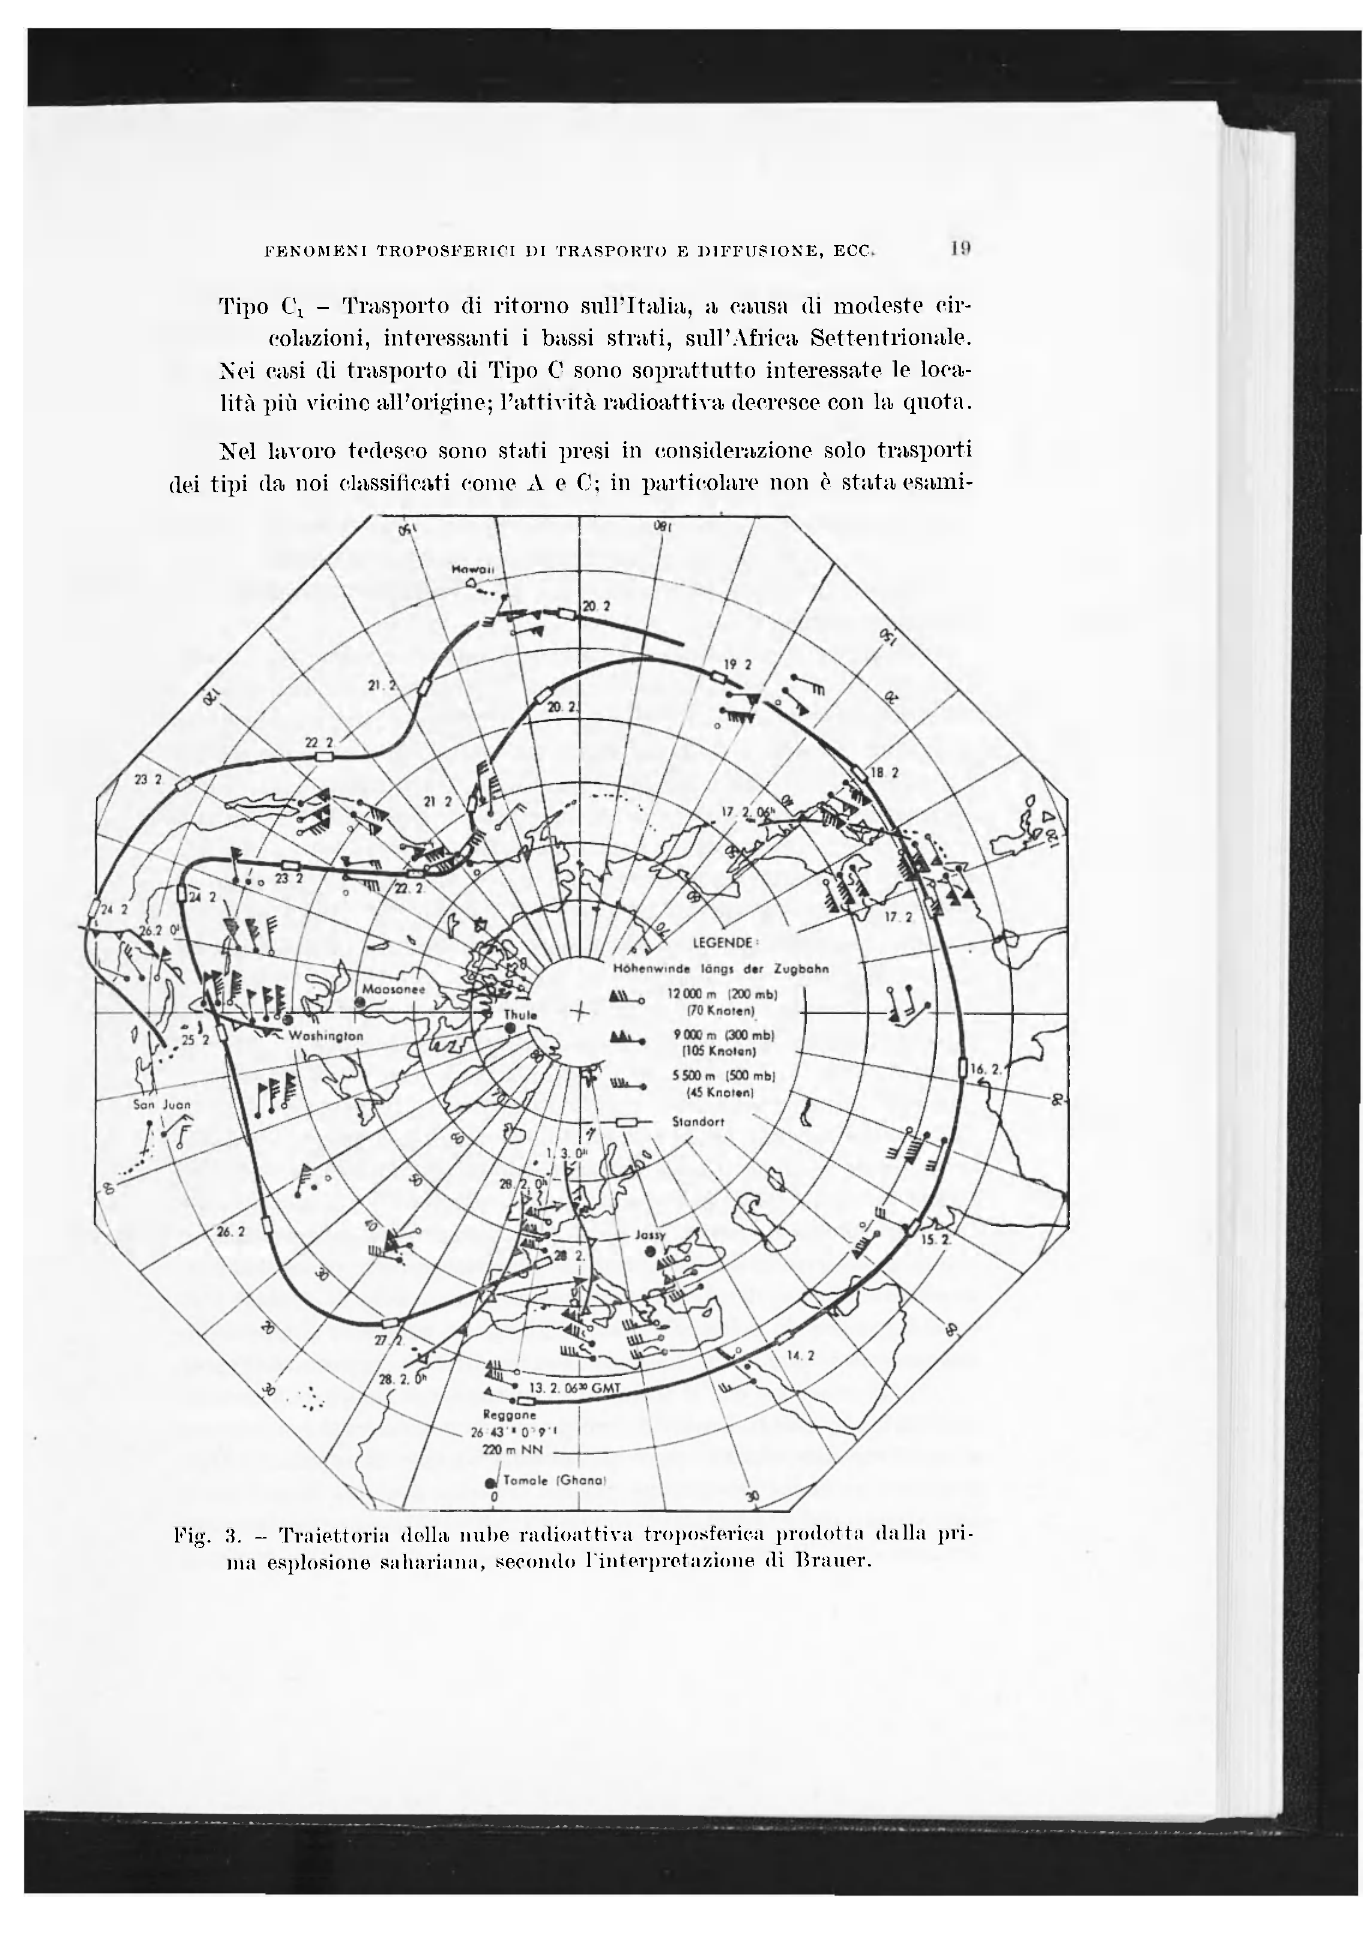
Fig. 3. - Traiettoria della nube radioattiva troposferica prodotta dalla pri- ma esplosione sahariana, secondo l'interpretazione di